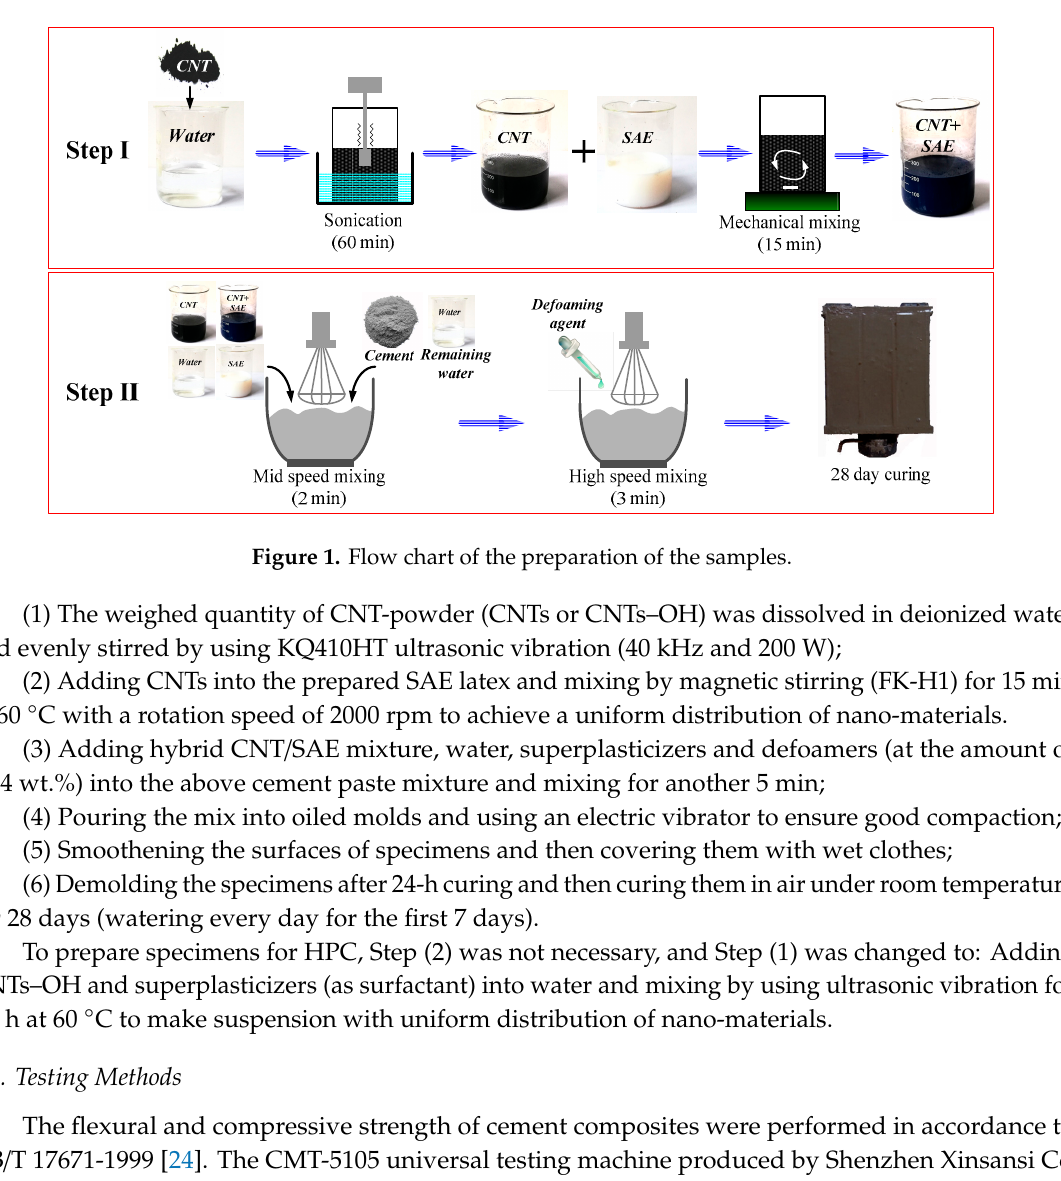
Figure 2. Loading setup of the flexural strength ( a ) and compressive strength tests ( b ).